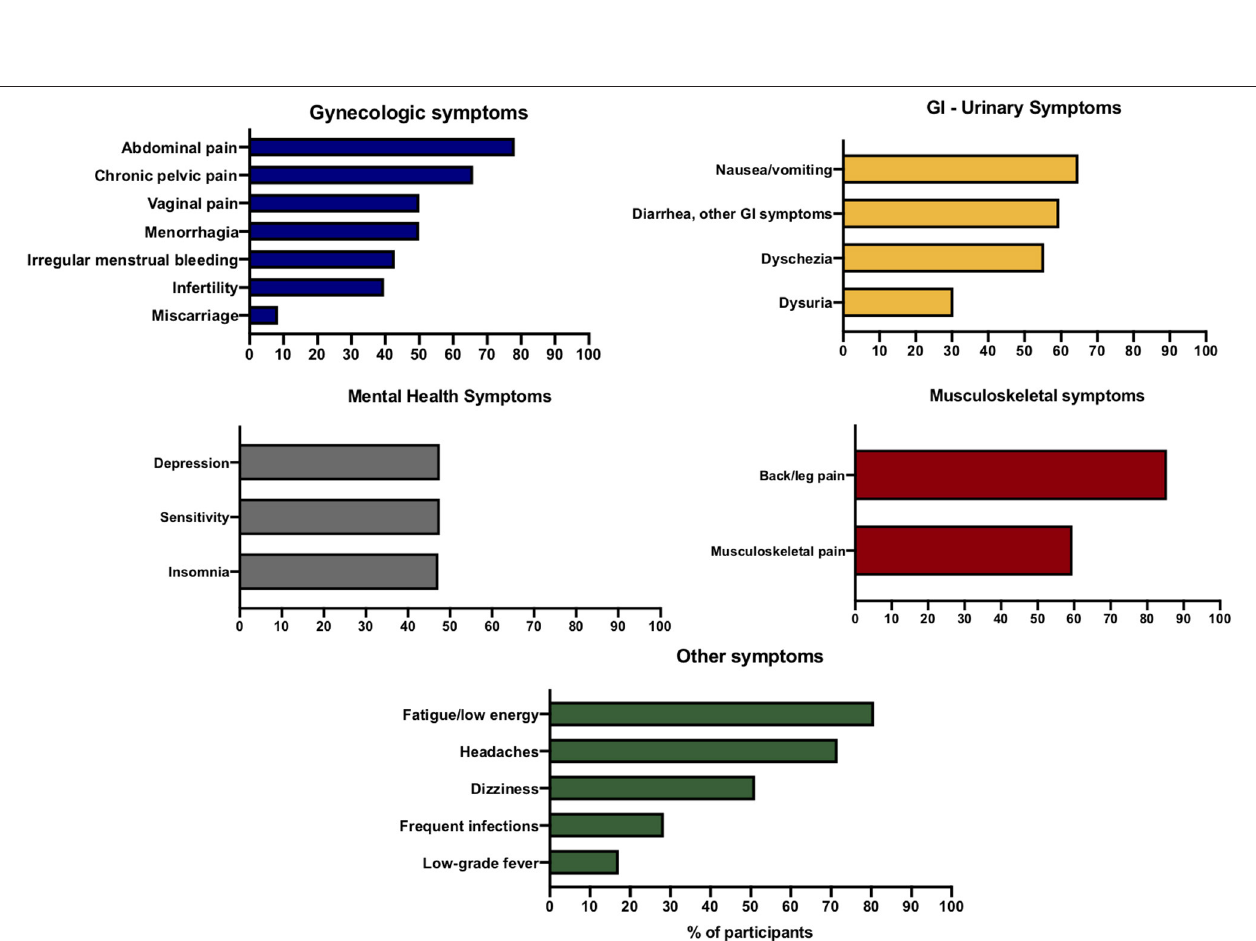
FIGURE 5 | The most common symptoms reported by participants organized by system.